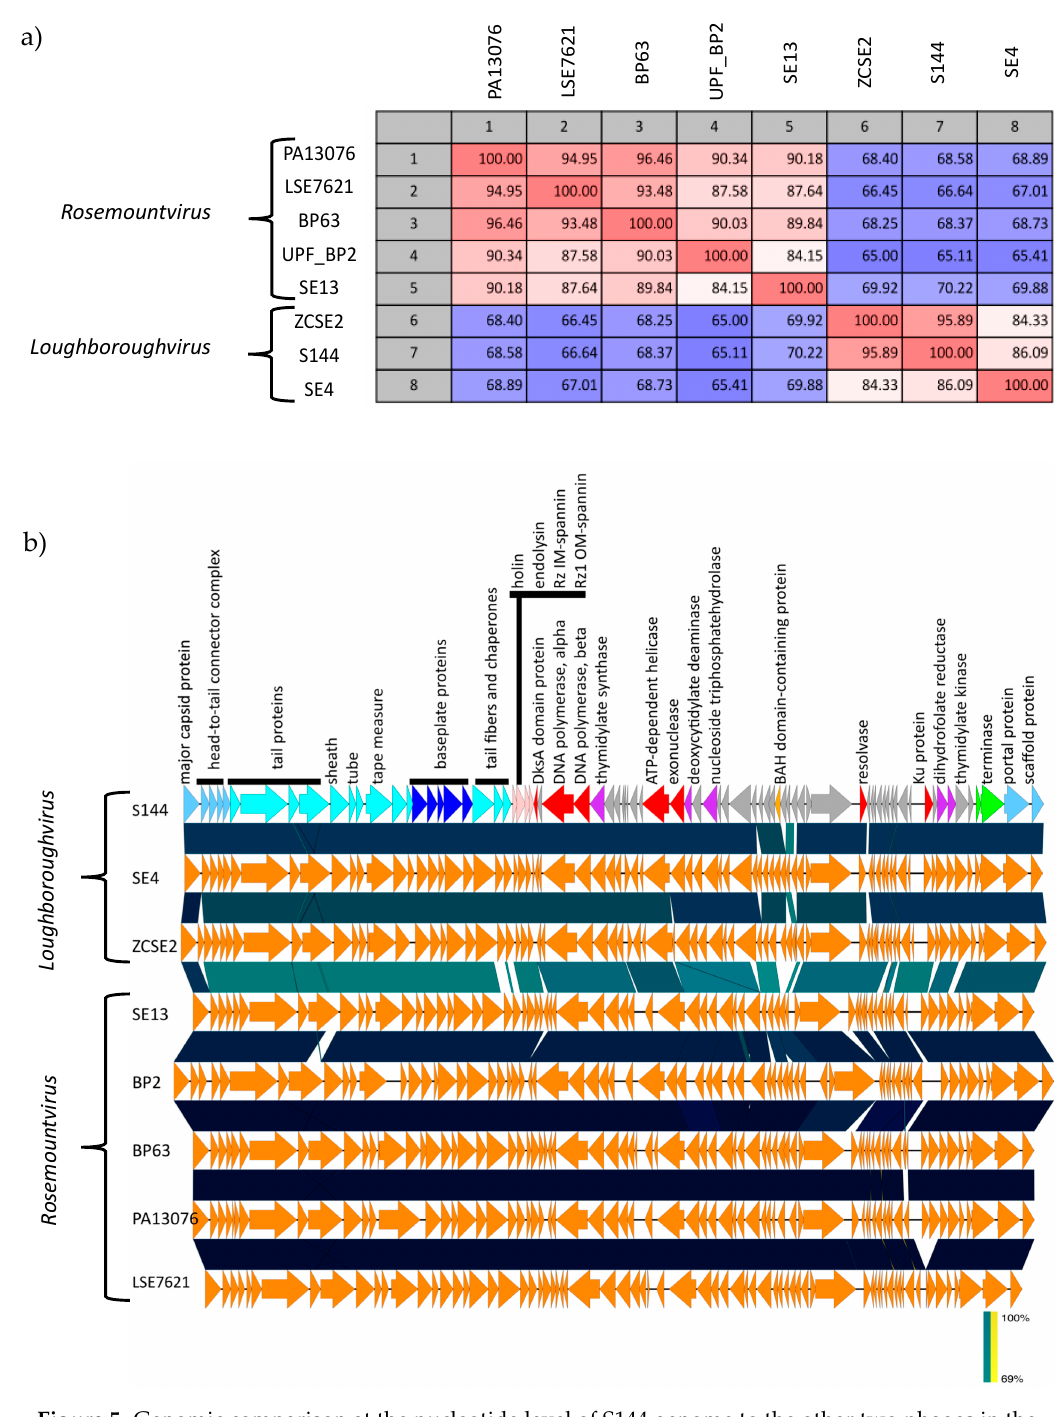
Figure 5. Genomic comparison at the nucleotide level of S144 genome to the other two phages in the Loughboroughvirus genus and five representatives from the closest genus, the Rosemountvirus genus. ( a ) Whole-genome pairwise comparison of the eight phage nucleotide sequences, visualized as a matrix with percent identity with CLC Main Workbench 7. ( b ) Organization and functional modules of the eight phage genomes. This figure was generated using EasyFig. Genes for phage morphogenesis are marked in blue (light blue: capsid, cyan: tail, blue: baseplate), genes for DNA packaging in green, putative genes for lysis in pink, genes involved in DNA manipulation in red, putative genes for nucleotide biosynthesis in purple and additional functions in ochre (prot. = protein). Blue shade indicates the level of similarity.